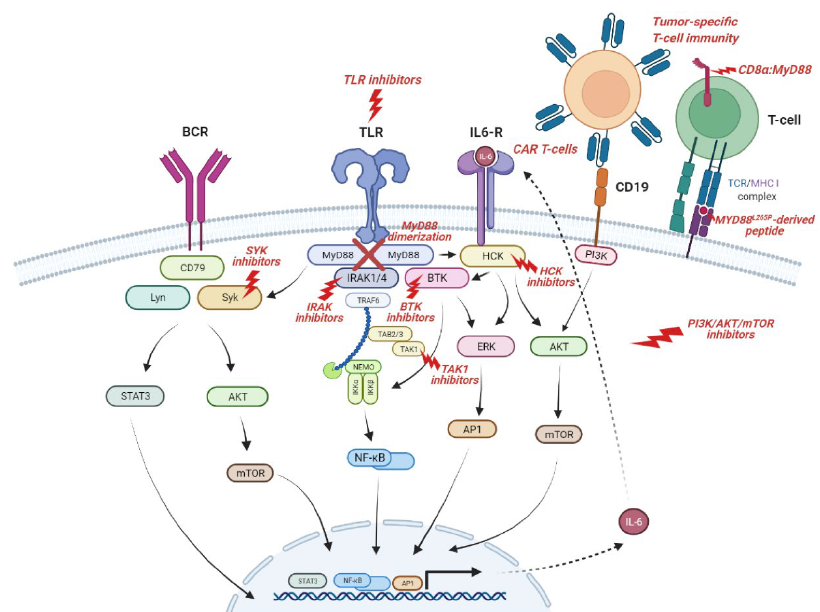
Figure 2. Representation of the MyD88 and related pathways that can be targeted by specific drugs. Components of the pathways activated by MYD88 L265P mutation, such as BTK, IRAKs, and HCK, have proven to be relevant targets for lymphomas. MyD88 is also being used for T-cell immunotherapy as part of CAR T cells, synthetic coreceptors (CD8α:MyD88), or peptides that can induce T-cell responses.